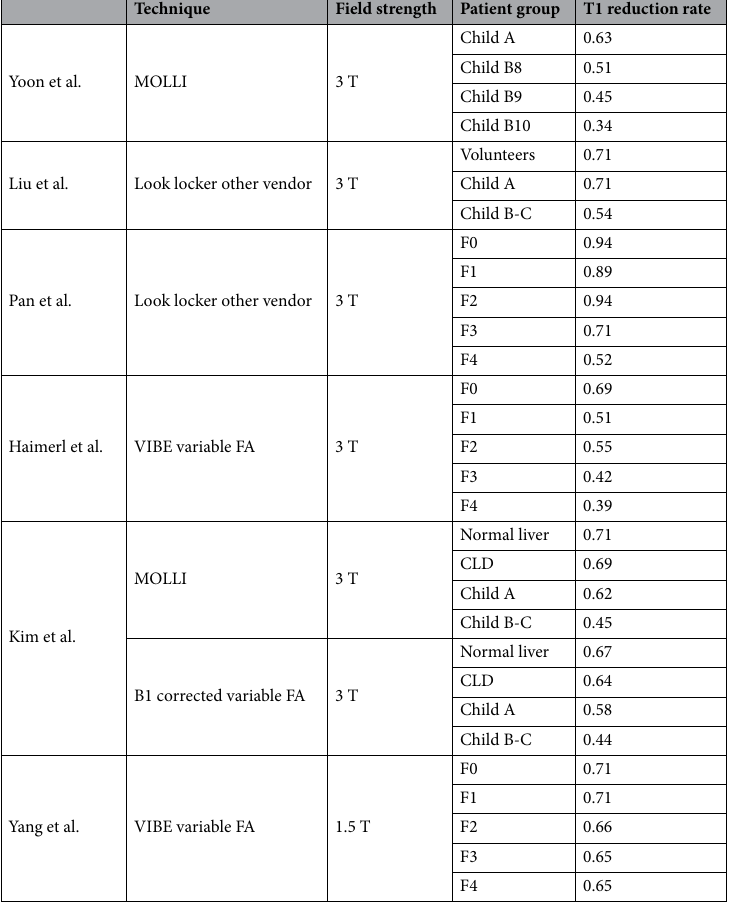
Table 5. T1 reduction rates comparison. MOLLI: modified look locker inversion recovery sequence, FA: flip angle, VIBE: volumetric interpolated breath-hold examination, CLD: chronic liver disease, Child A, B, C: Child Pugh group A, B,